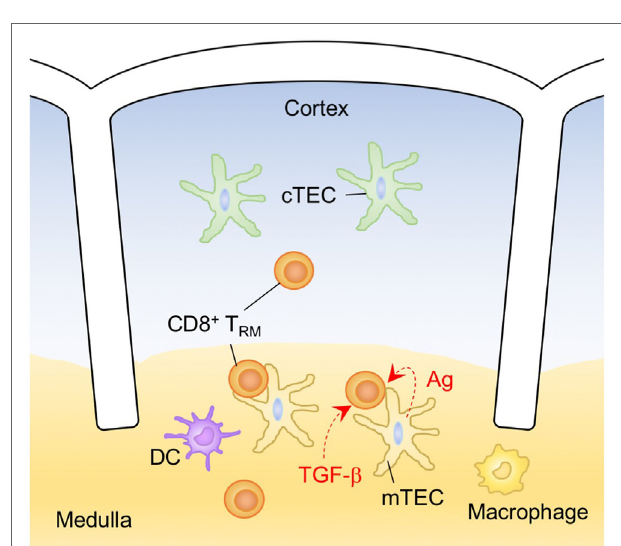
FiGURe 9 | T RM niches in the in the thymus. CD8 + T RM cells are localized predominantly within the thymic medulla, although some cells are also found in the cortex. A majority of CD8 + T RM cells in the thymus express CD103 and CD69. TGF- β is rich in the medulla, and presumably influences the CD8 + T cell expression of CD103. Since persistent presentation of foreign antigen in the thymus is uncommon, self-antigen may drive the expression of CD69 on thymic CD8 + T RM cells. Orange cells indicate CD8 + T RM cells unless otherwise stated. Dashed lines indicate potential impact of niche factors. Abbreviations: Ag, antigen; cTEC, cortical thymic epithelial cell; mTEC, medullary thymic epithelial cell; T RM , tissue-resident memory T cells.